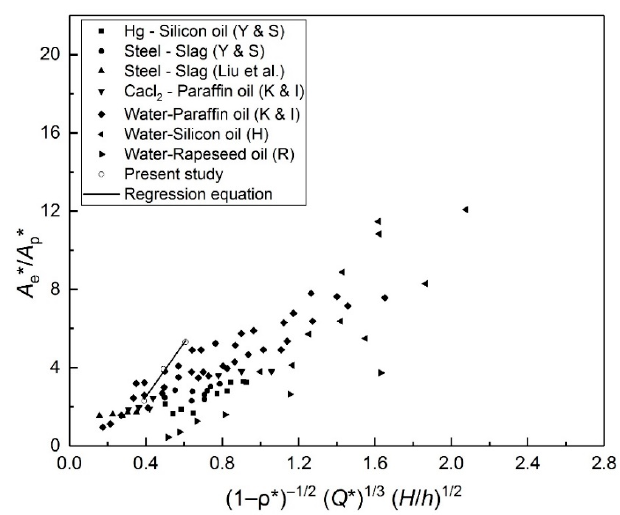
Figure 8. Comparison of non-dimensional open-eye area ratio with the literature (K & I: Krishnapisharody and Irons [6]; Yonezawa and Schwerdtfeger [5]; Han et al. [37]; E. Ramasetti et al. (cid:3117) (cid:3117) (cid:3009) (cid:3118) ). (cid:4673) [36]: ( 𝐴 (cid:3032)∗ /𝐴 (cid:3043)∗ ) 𝑣𝑠.(𝑄 ∗ ) (cid:3119) (cid:4672) (cid:3035)